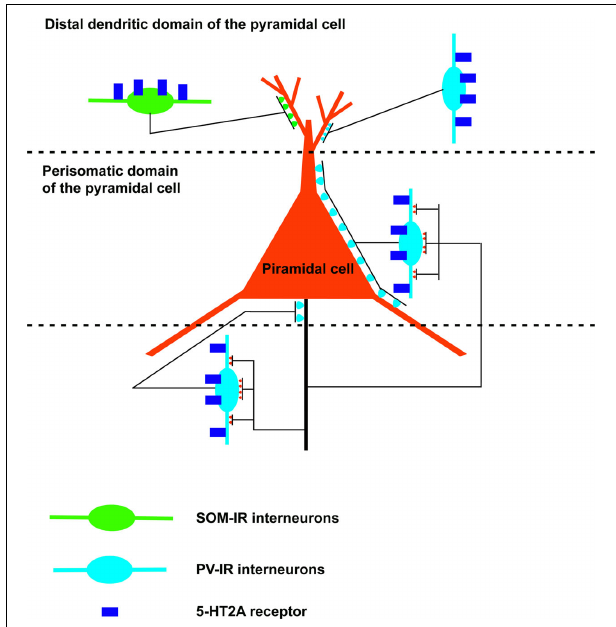
FIGURE 3 | Schematic drawing of a neuronal microcircuit expressing the 5-HT 2A receptor in the rat basolateral amygdala. The 5-HT 2A receptor is located in excitatory (pyramidal cells) as well as inhibitory neurons. In particular, this receptor is expressed by GABAergic interneurons which innervate the initial axonal segment (parvalbumin-immunoreactive [IR] chandelier cells), the cell body and proximal dendrites (parvalbumin-IR basket cells), and the distal dendrites (somatostatin-IR cells; parvalbumin-IR interneurons) of the pyramidal cells. Note the reciprocal perisomatic connection between pyramidal cells and parvalbumin-IR interneurons (chandelier and basket